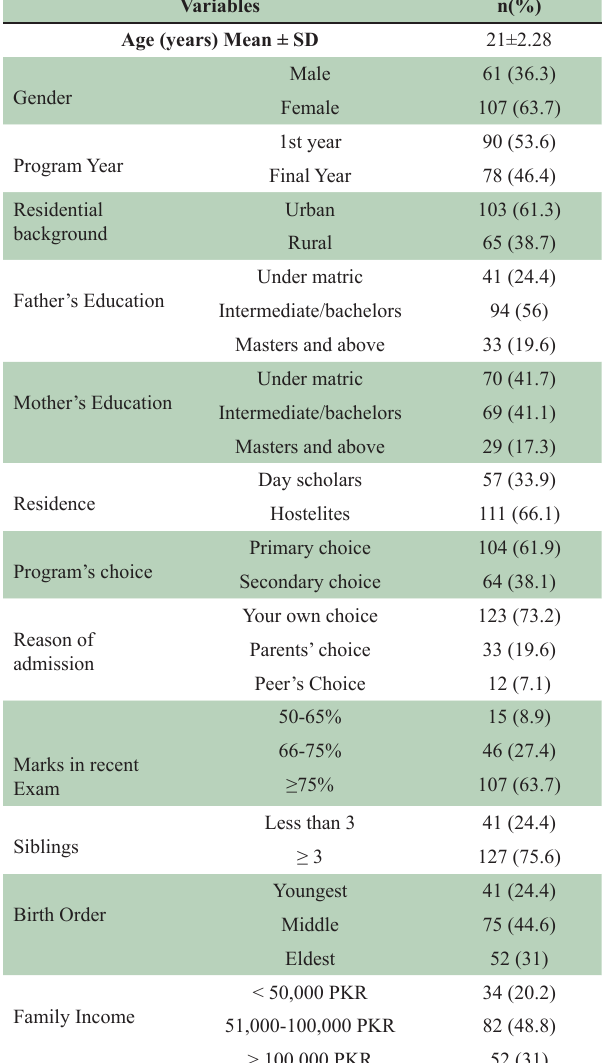
Table-I: Characteristics of the study participants.